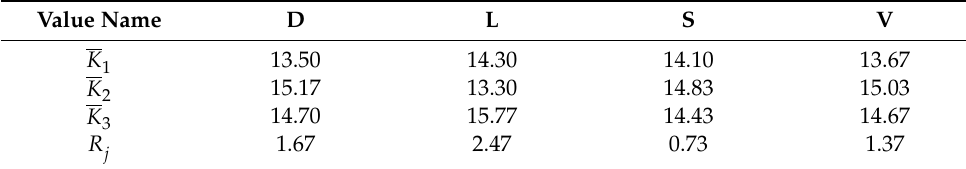
Figure 7. Photo of the designed equipment and LFM cleaning. Table 4. Range analysis